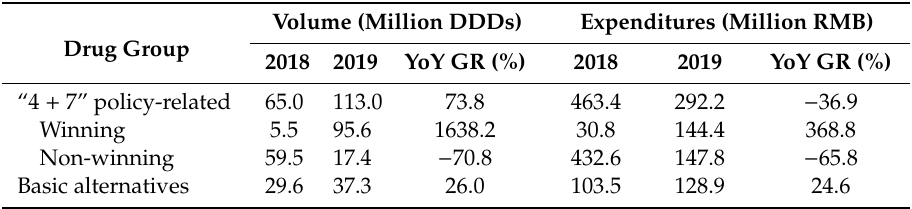
Table 1. Purchase volume, expenditures, and their year-on-year growth rate (YoY GR) of “4 + 7”